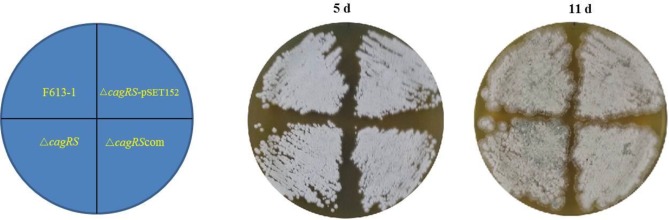
Phenotype of F613-1, ΔcagRS, ΔcagRS-pSET152, and ΔcagRS com on BCSA solid medium.